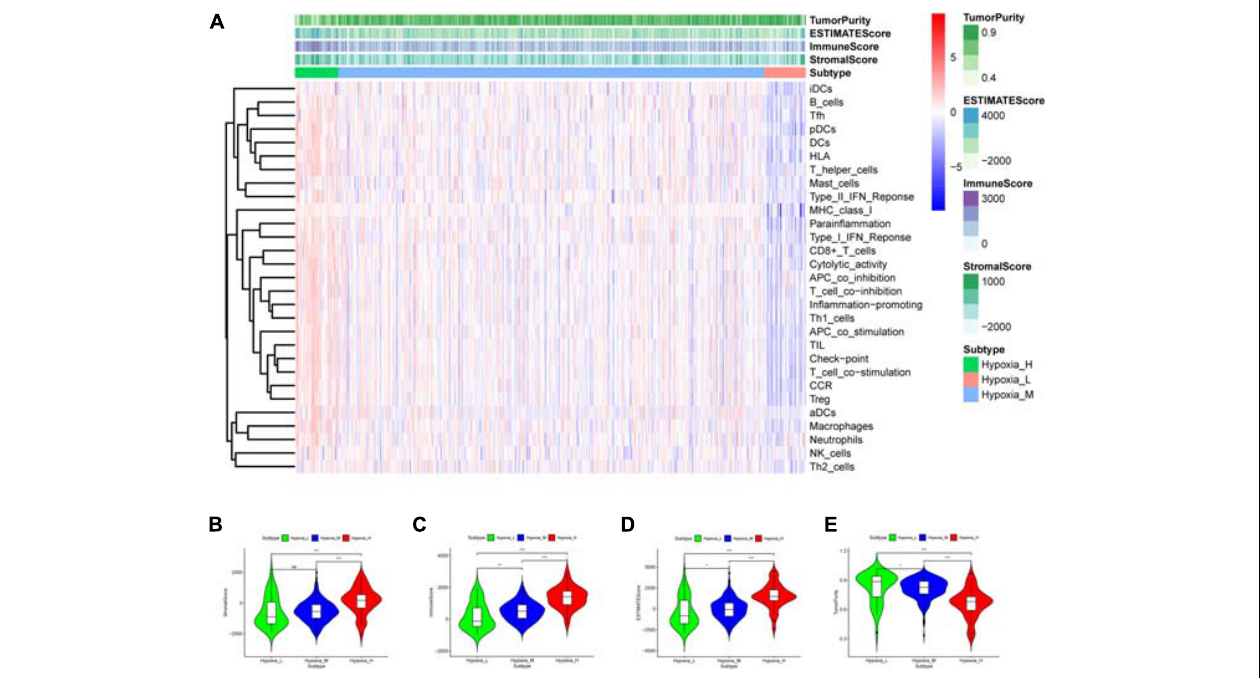
FIGURE 8 | Immune status analysis of tumor microenvironment. (A) Heat map. The abscissa represents the sample name and the ordinate represents the immune gene set. The upper part is tumor microenvironment scores, in which StromalScore, ImmuneScore and ESTIMATEScore decrease with the decrease of hypoxia degree, suggesting that the content of corresponding cells decrease. Tumor purity is opposite to them. (B–E) Violin plot. The correlation between the hypoxia degree and each tumor microenvironmental parameter is statistically analyzed. *** P < 0.001, ** P < 0.01, * P < 0.05, ns P >